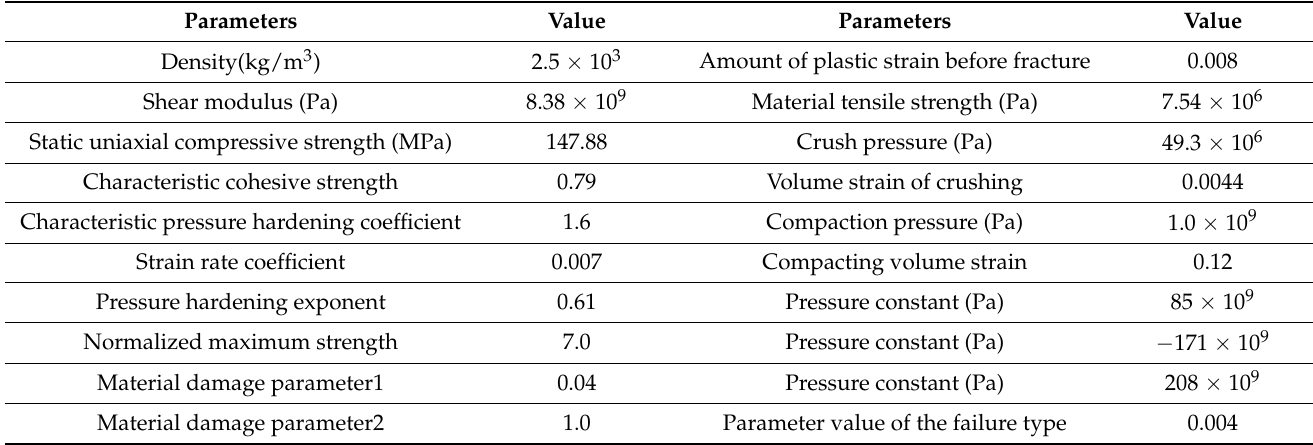
Table 2. Rock parameter settings.